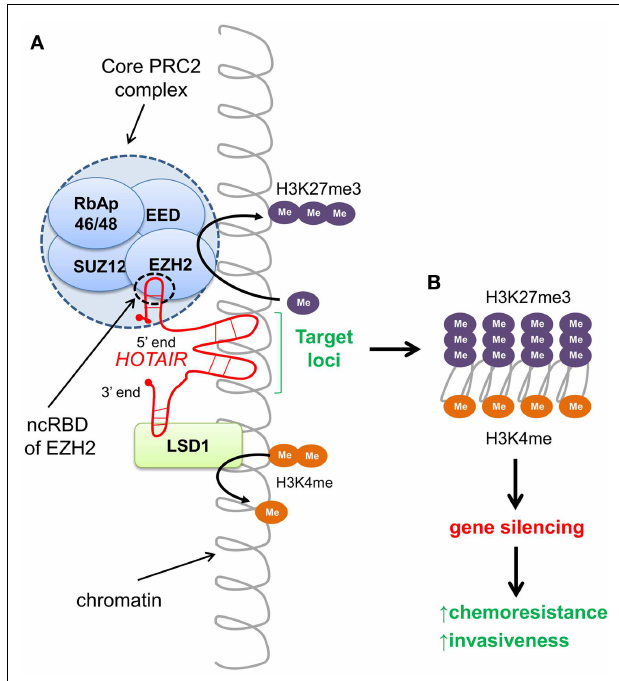
FIGURE 2 | HOTAIR -directed epigenetic reprograming of the cancer genome . (A) The long intergenic non-coding (linc) RNA HOTAIR recognizes specific DNA sequences and targets chromatin-modifying complexes PRC2 and LSD1 to silence gene loci.The 5 (cid:48) end of HOTAIR tethers the PRC2 complex to the target by binding to the non-coding RNA binding domain (ncRBD) of the HMTase EZH2, catalyzing tri-methylation of H3K27.The 3 (cid:48) end of HOTAIR facilitates demethylation of H3K4me2 by the lysine-specific demethylase LSD1. Both H3K27me3 and lack of methylation at H3K4 are repressive chromatin marks associated with gene silencing. (B) Expression of HOTAIR results in silencing of > 40-kb region spanning HOXD8–11 of the HOXD locus. Aberrant HOTAIR expression in multiple cancers has been shown to promote